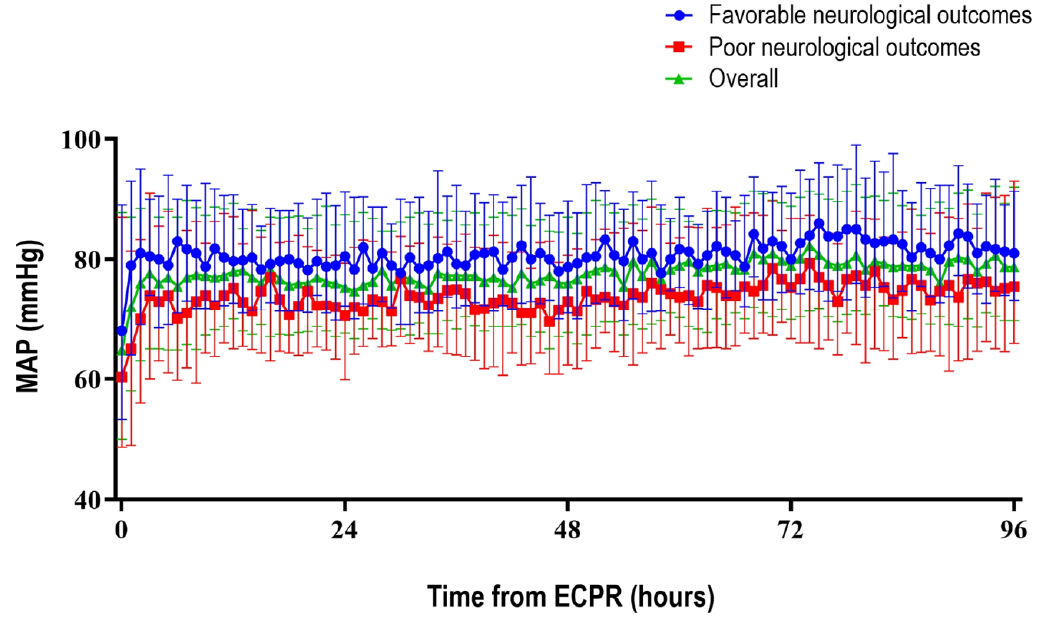
Figure 2. The trends of mean arterial pressure (MAP) after extracorporeal cardiopulmonary resuscitation (ECPR).